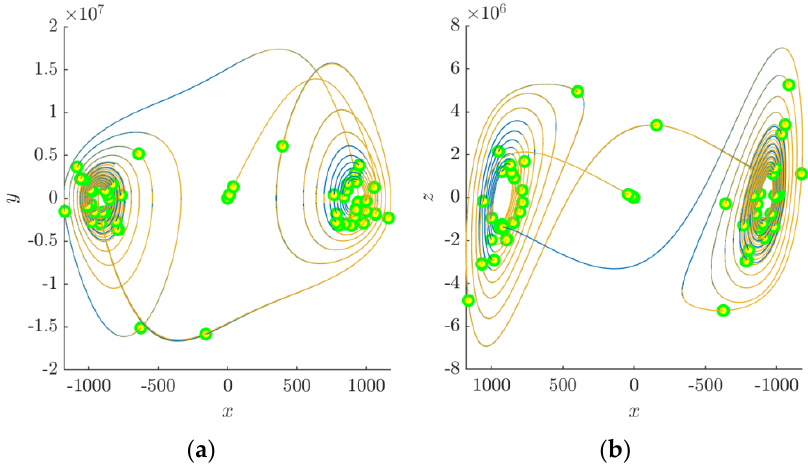
Figure 8. The trajectory of the system Equations in (40) projected onto ( a ) x-y plane and ( b ) x-z plane. The green Dots denote 53 data points, the blue line depicts the original trajectory, and the orange line depicts a trajectory of the reconstructed system scaled to fit the original trajectory. The equations were reconstructed with high accuracy.